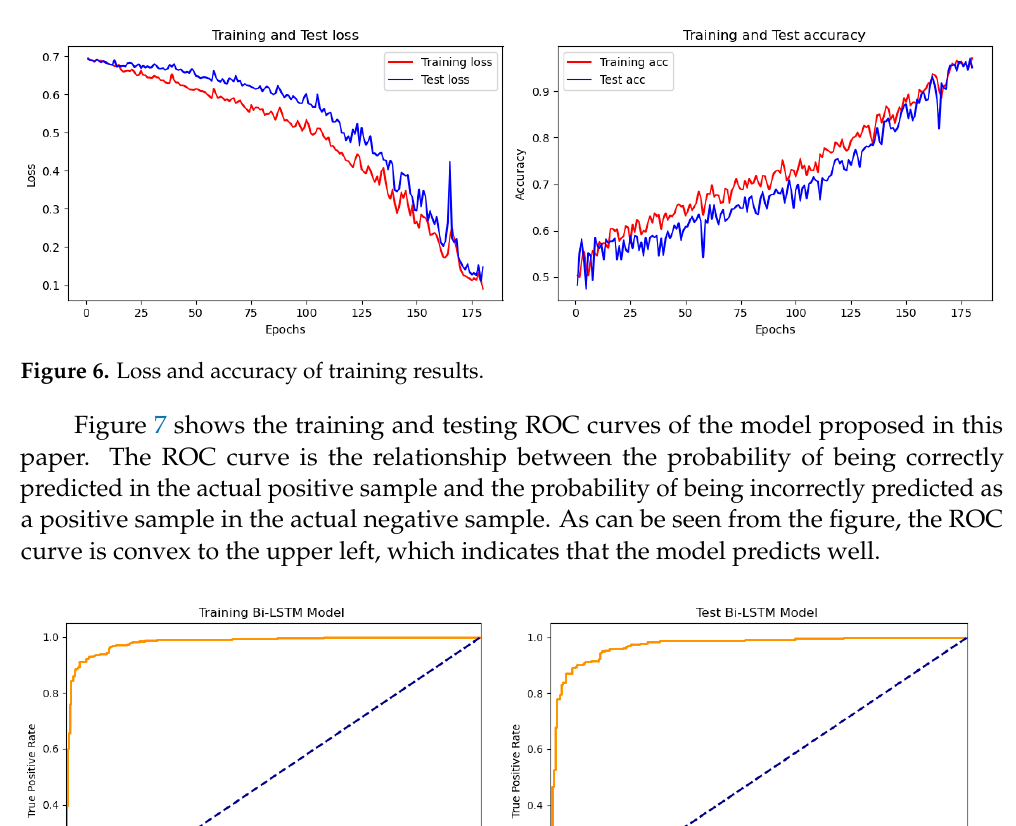
Figure 6. Loss and accuracy of training results.